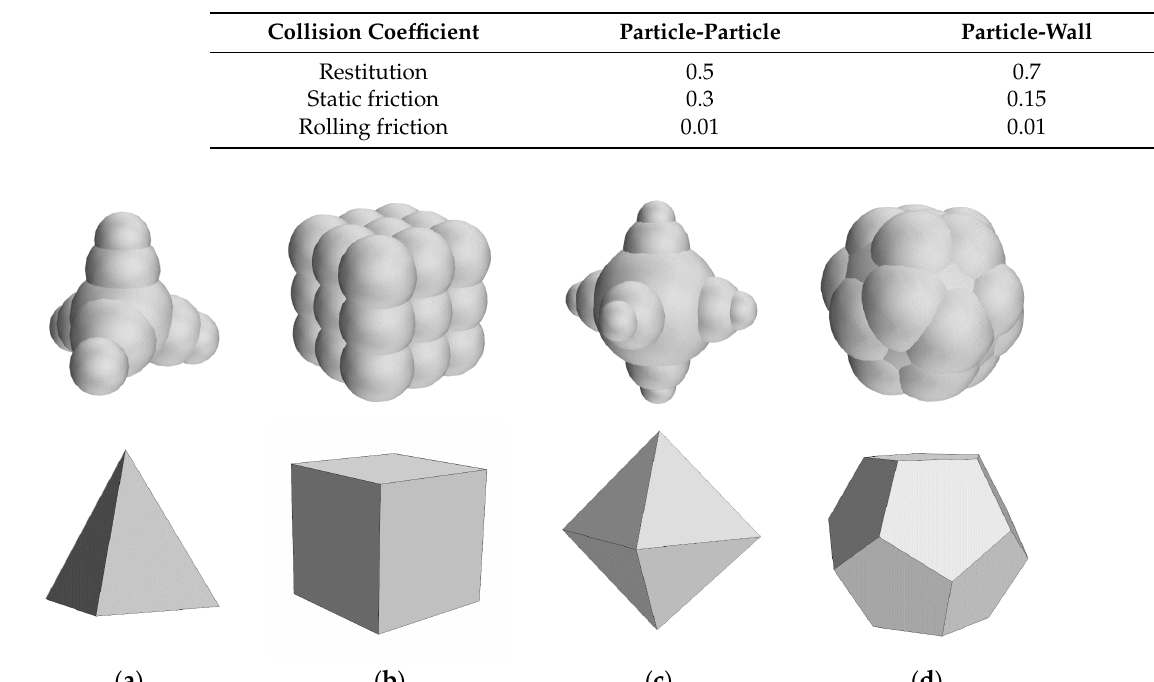
Figure 2. Particle DEM and geometrical models: ( a ) tetrahedron, ( b ) hexahedron, ( c ) octahedron, ( d ) dodecahedron. Table 2. Particle configurations.